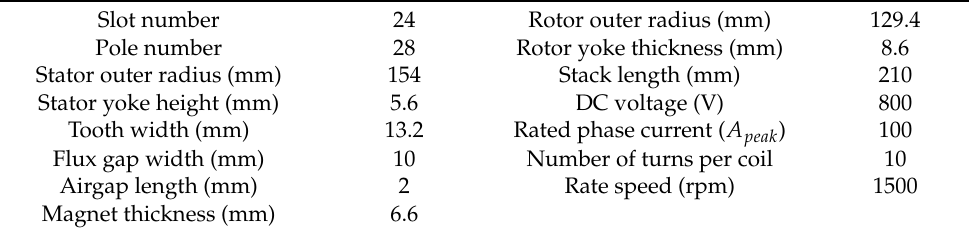
Table 1. Parameters of modular SPM